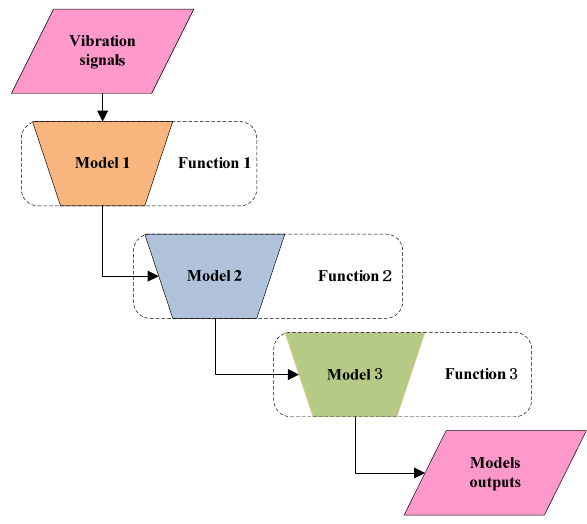
Figure 9. Waterfall model fusion.